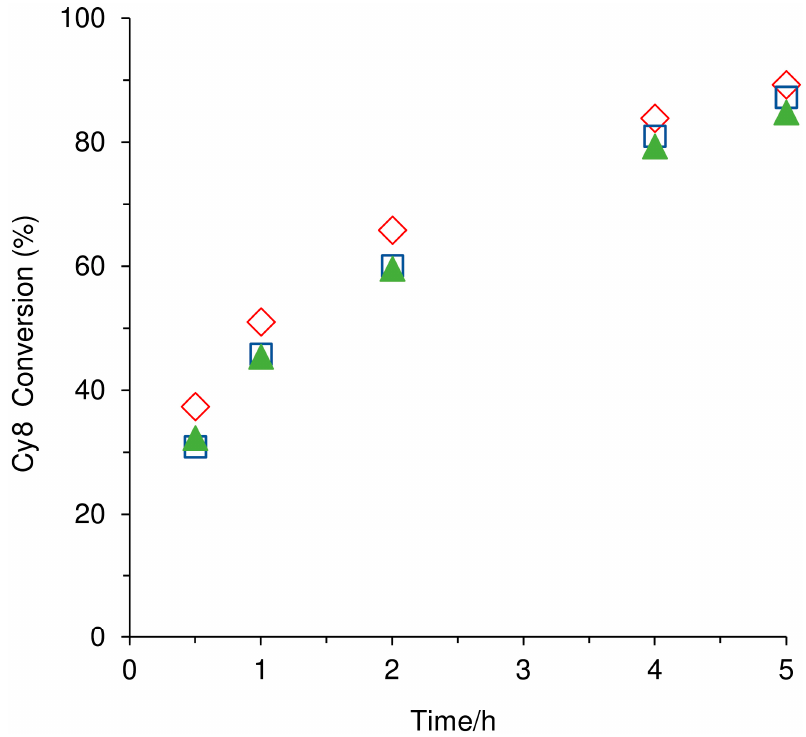
Figure 12. Catalyst stability of 2 in consecutive batch runs of Cy8 epoxidation with TBHP in TFT at 70 °C: ( ◇ ) run 1, ( □ ) run 2, ( ▲ ) run 3.